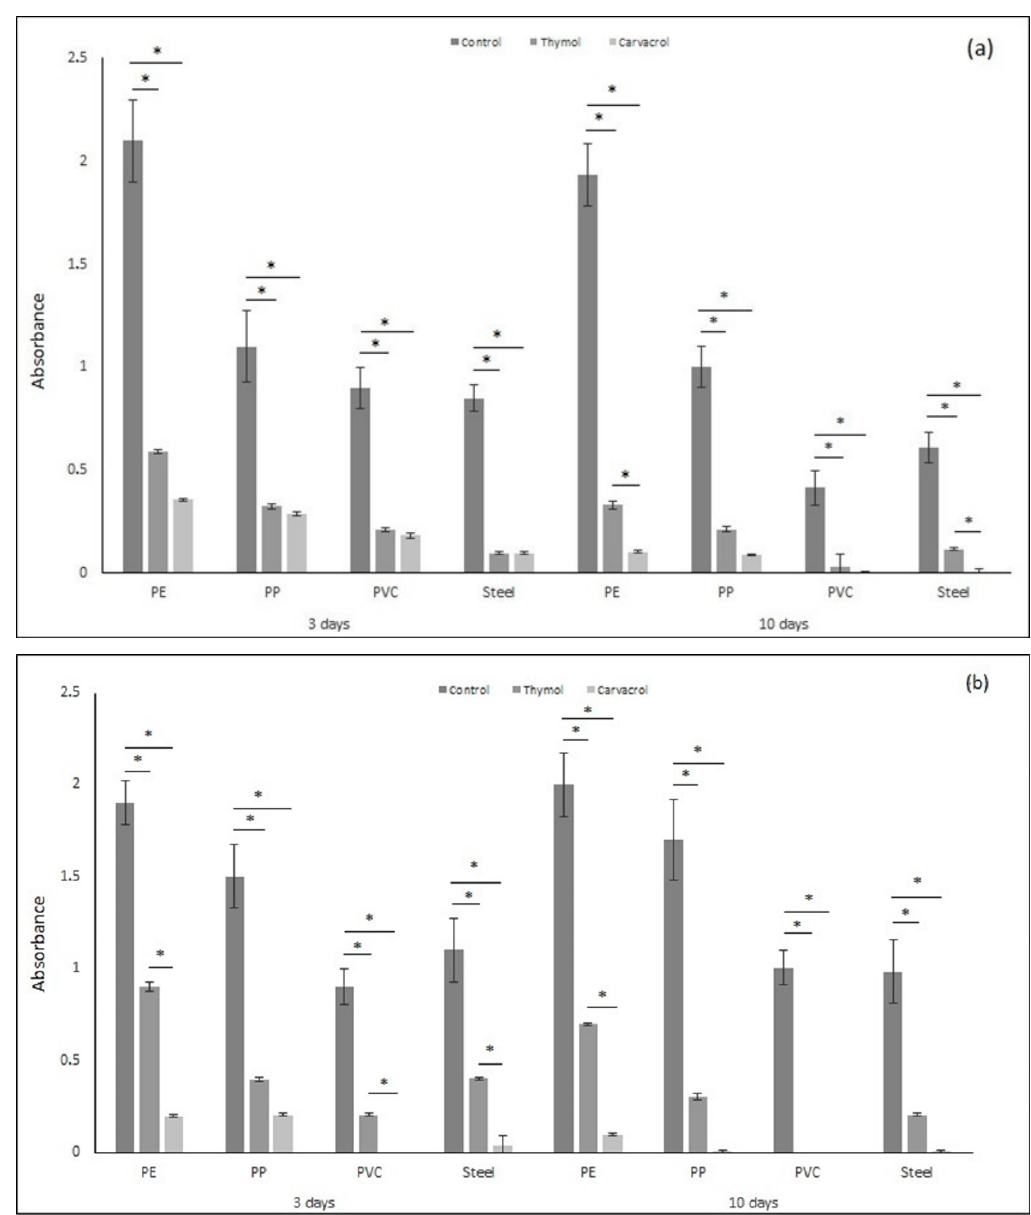
Figure 2. The total amount of biofilm (based on absorbance) formed by ( a ) Pseudomonas aeruginosa and ( b ) Staphylococcus aureus on materials (PE, PP, PVC, and stainless steel) after applying tested substances (thymol and carvacrol) according to the time of exposure. All analyses were performed in triplicate. Data are presented as mean ± SD (one-way ANOVA test and Tukey test were performed to determine the statistical significance between the indicated groups (* p < 0.05)).